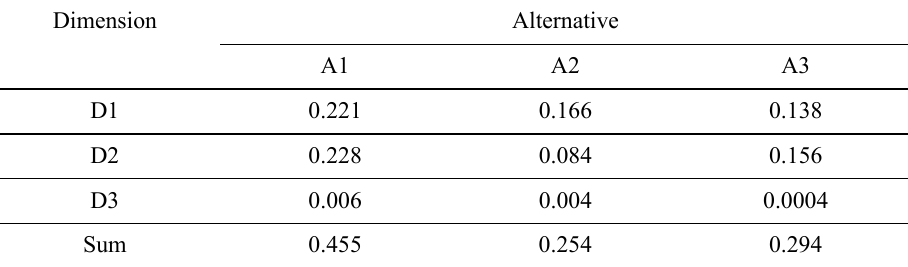
Table 11. Results of competitive strategy